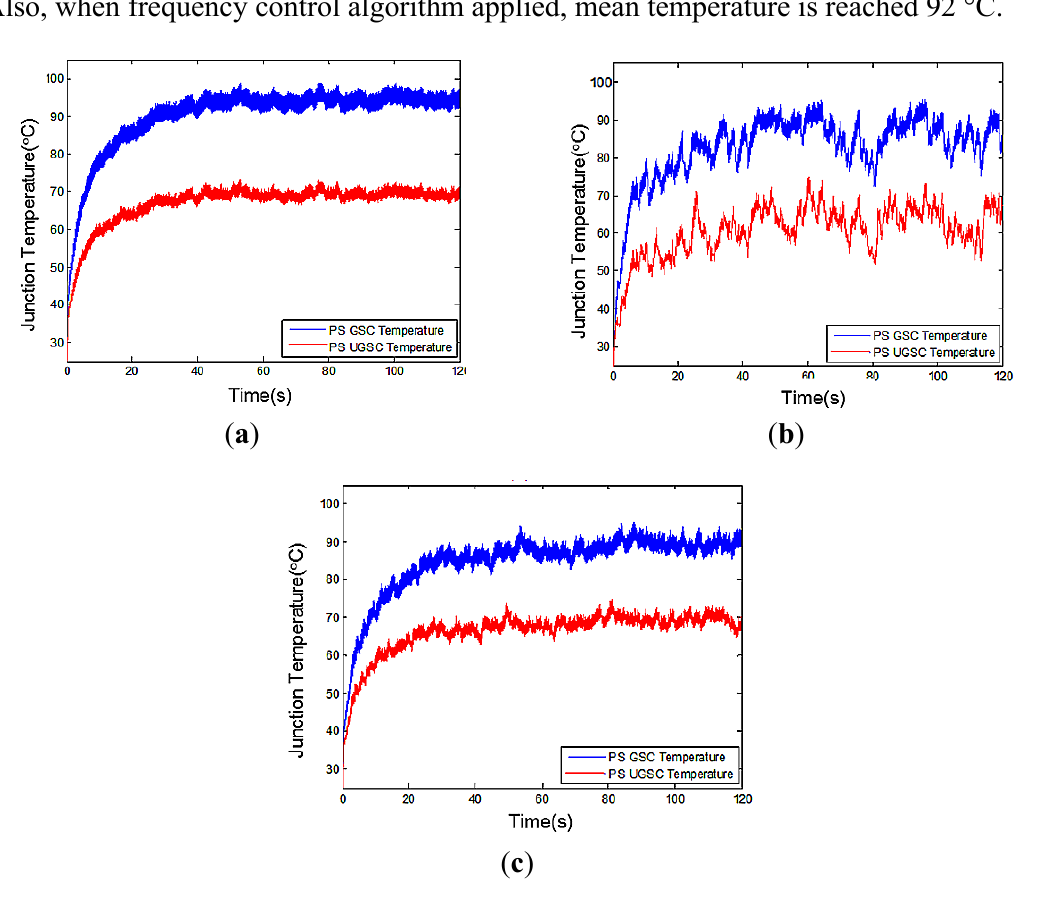
Figure 13. Temperature Profile of PS based PECs with ( a ) conventional fixed DC link voltage; dynamic DC link ( b ) without and ( c ) switching frequency adaption schemes in GS and UGS.